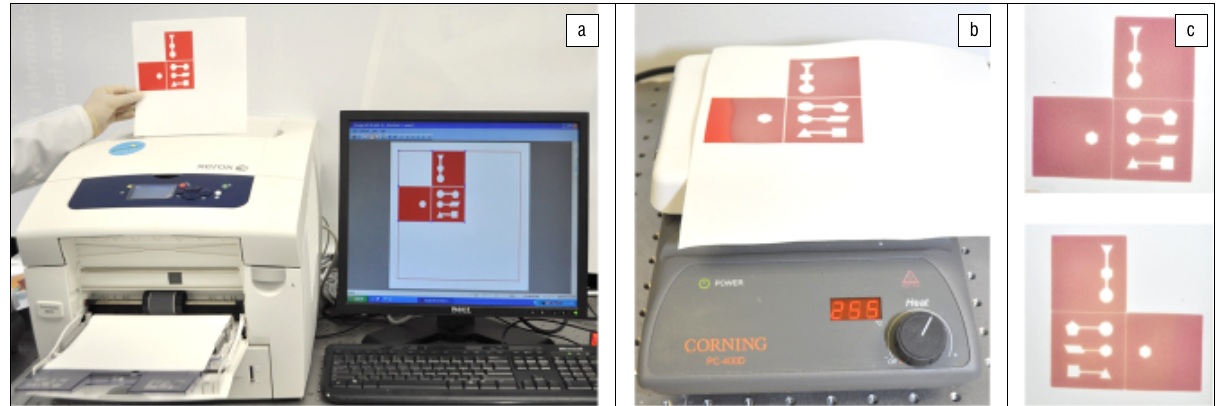
Figure 2: (a) Printing of wax device design onto chromatography paper from a computer aided design drawing using a wax printer connected to a computer, followed by (b) melting of the wax through the paper using a hot plate at 255 °C. (c) The front and back of the finished device after the melting stage. Complete infiltration of the wax through the paper device is